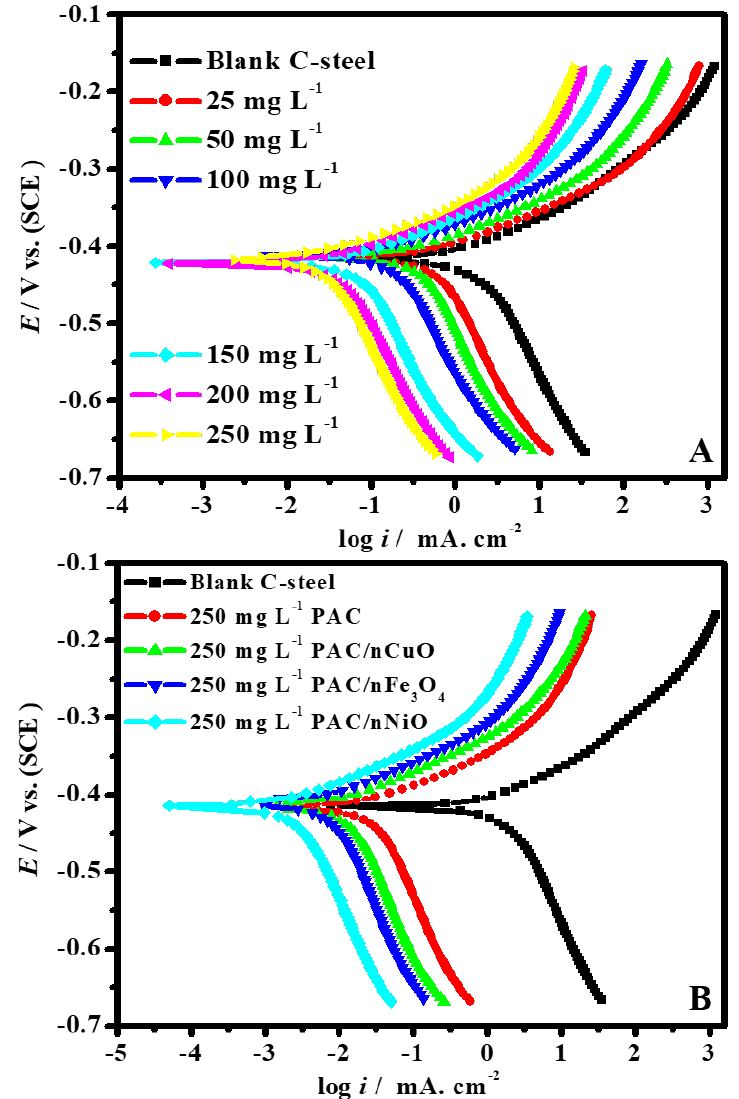
Figure 7. Tafel polarization profiles for C-steel in 1.0 M HCl solution without and with different concentrations of PAC ( A ) and in the presence of 250 mg L − 1 of different nanocomposite inhibitors at 50 °C ( B ).